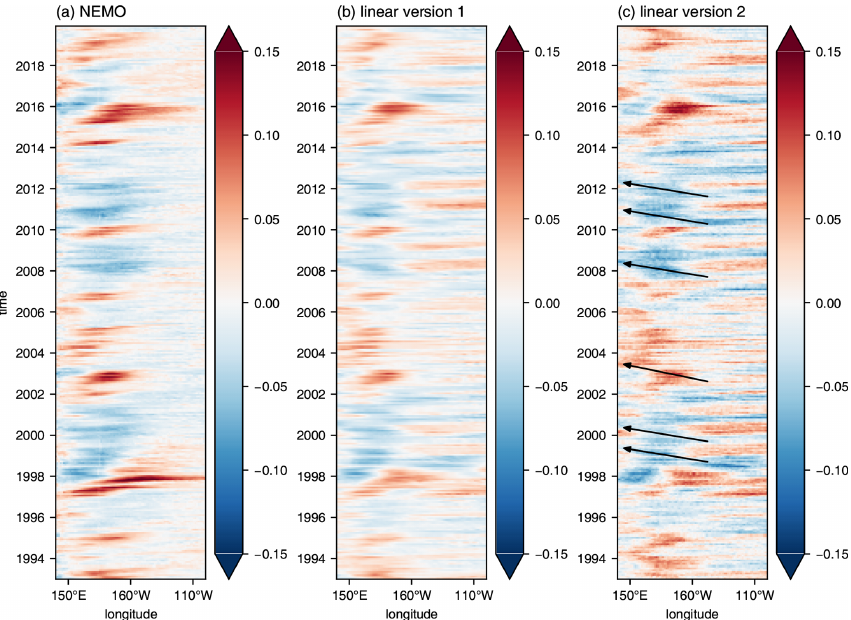
Figure 8. Hovmöller diagrams (units of metres) along the Equator of (a) η nlti computed from the NEMO model simulation, (b) η nlti computed using Version 1 of the linear model using SSH from the NEMO model, and (c) η nlti computed using Version 2 of the linear model using AVISO data. The arrows indicate selected events exhibiting westward propagation, and the labelling for the years corresponds to 1 January.